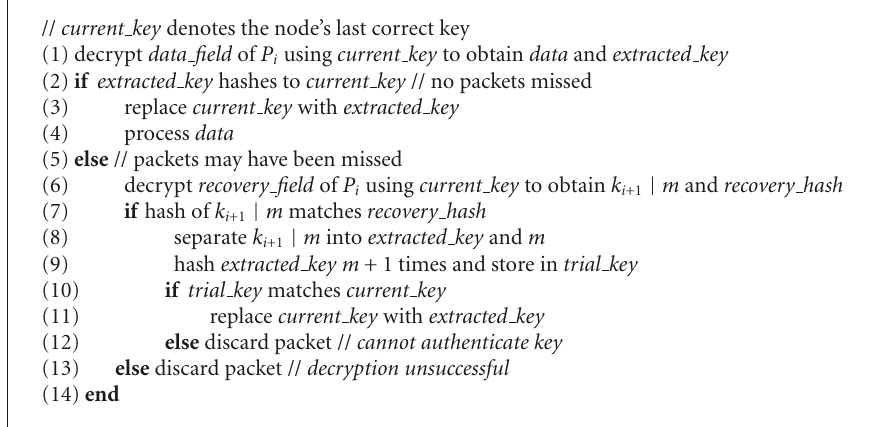
Algorithm 1: Operations performed by node upon arrival of broadcast packet P i